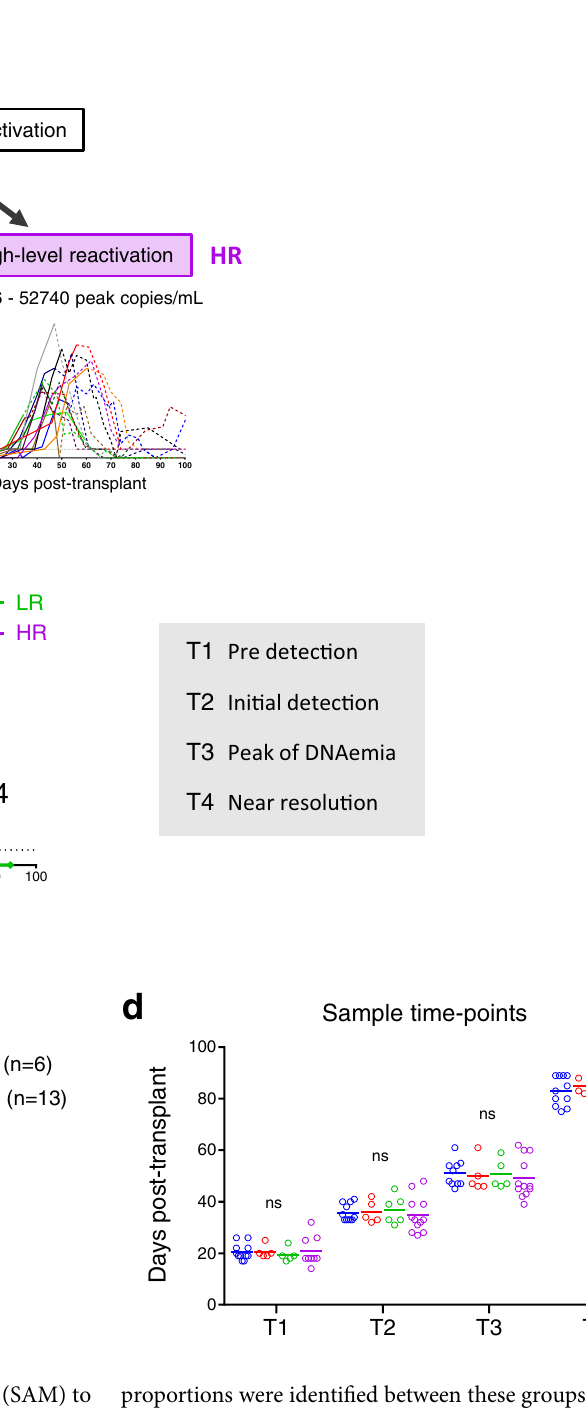
proportions were identi fi ed between these groups (Fig. 3a). At T2, however, multiple cell phenotypes indicative of immune activa- tion were enriched in reactivators at T2 (Fig. 3a), including ele- vated percentages of CD86 + monocyte subsets and myeloid dendritic cells (mDC), HLA-DR + CD38 + total and EM CD4 + and CD8 + T cells, and higher EM, PD-1 + , and ICOS + percen- tages in the CD4 + T cell compartment (Fig. 3a). Total